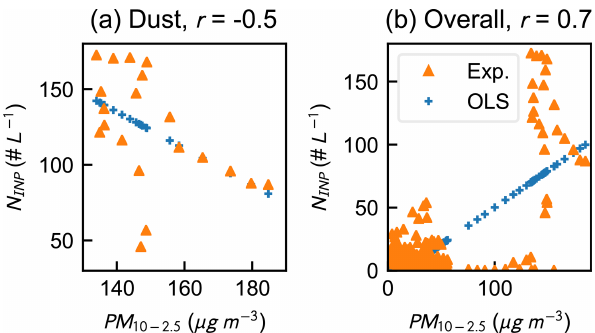
Figure C1. Correlations between PM 10–2.5 and N INP in the (a) dust event and (b) observation. The r above each panel is Pearson’s correlation coefficient. Blue markers indicate the predicted N INP using fitted linear regression